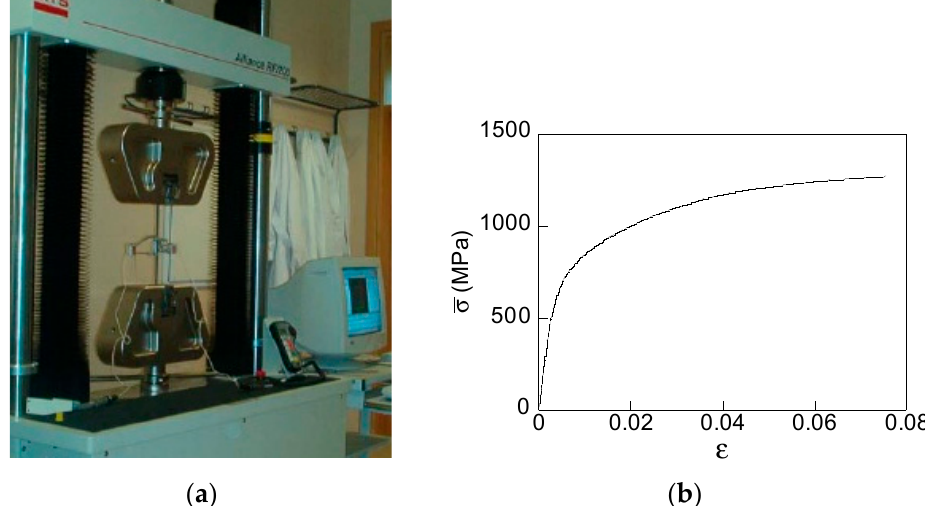
Figure 3. Conventional tension test: ( a ) experimental set-up and ( b ) experimental stress–strain curve of the material.